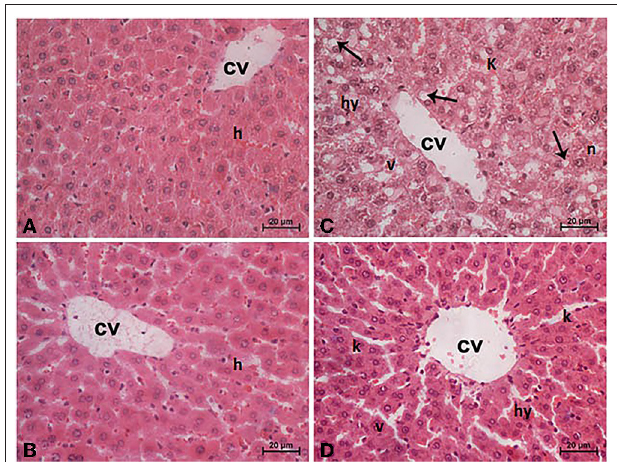
FIGURE 5 | Photomicrographs of liver tissues stained with hematoxylin and eosin in the control and TPJ group (A,B) , the acrylamide-treated group (C) , and the group co-treated with acrylamide and TPJ (D) . Sections from control and TPJ groups (A,C) show the liver consisted of CV surrounded by hepatic cords (h). The cords consisted of large hepatocytes with centrally located nuclei and acidophilic cytoplasm. Sections from the acrylamide-treated rats (B) the liver tissue showed vacular degeneration (v), hydrobic degeneration (hy). The liver tissues showed proliferation of the vonkupher cells (k). The blood sinusoids showed cellular infiltrates ( Table 5 ). Co-treatment of rats with acrylamide and TPJ (D) showed less vacuolar and hydrobic degeneration in some hepatocytes. Some vonkupher cells still proliferated but were not numerous compared with the acrylamide group. Scale bar = 20 µ m (original magnification = 200 × ). The morphometric and scoring of hepatic lesions are shown in Table 5 .